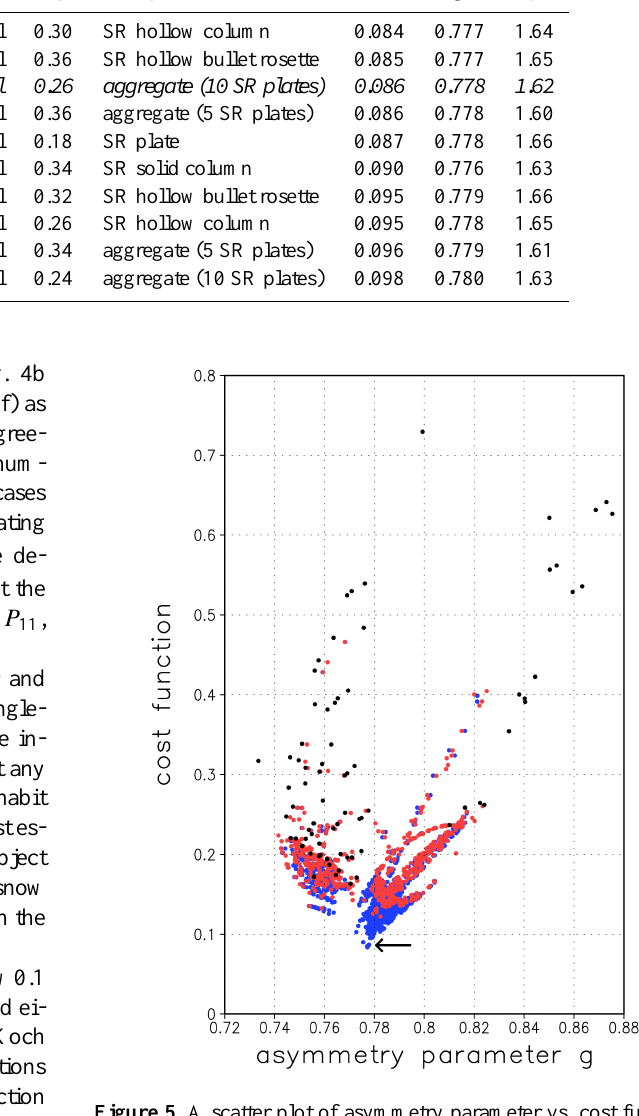
Figure 5. A scatter plot of asymmetry parameter vs. cost function (Eq. 4) for single habits (black dots), combinations of two habits (red dots) and combinations of three habits (blue dots). The “op- timized habit combination” selected for parameterization of snow single-scattering properties is marked with an arrow. Note that some single-habit cases fall outside the range plotted here. These include spheres for which cost = 1.90 and g =